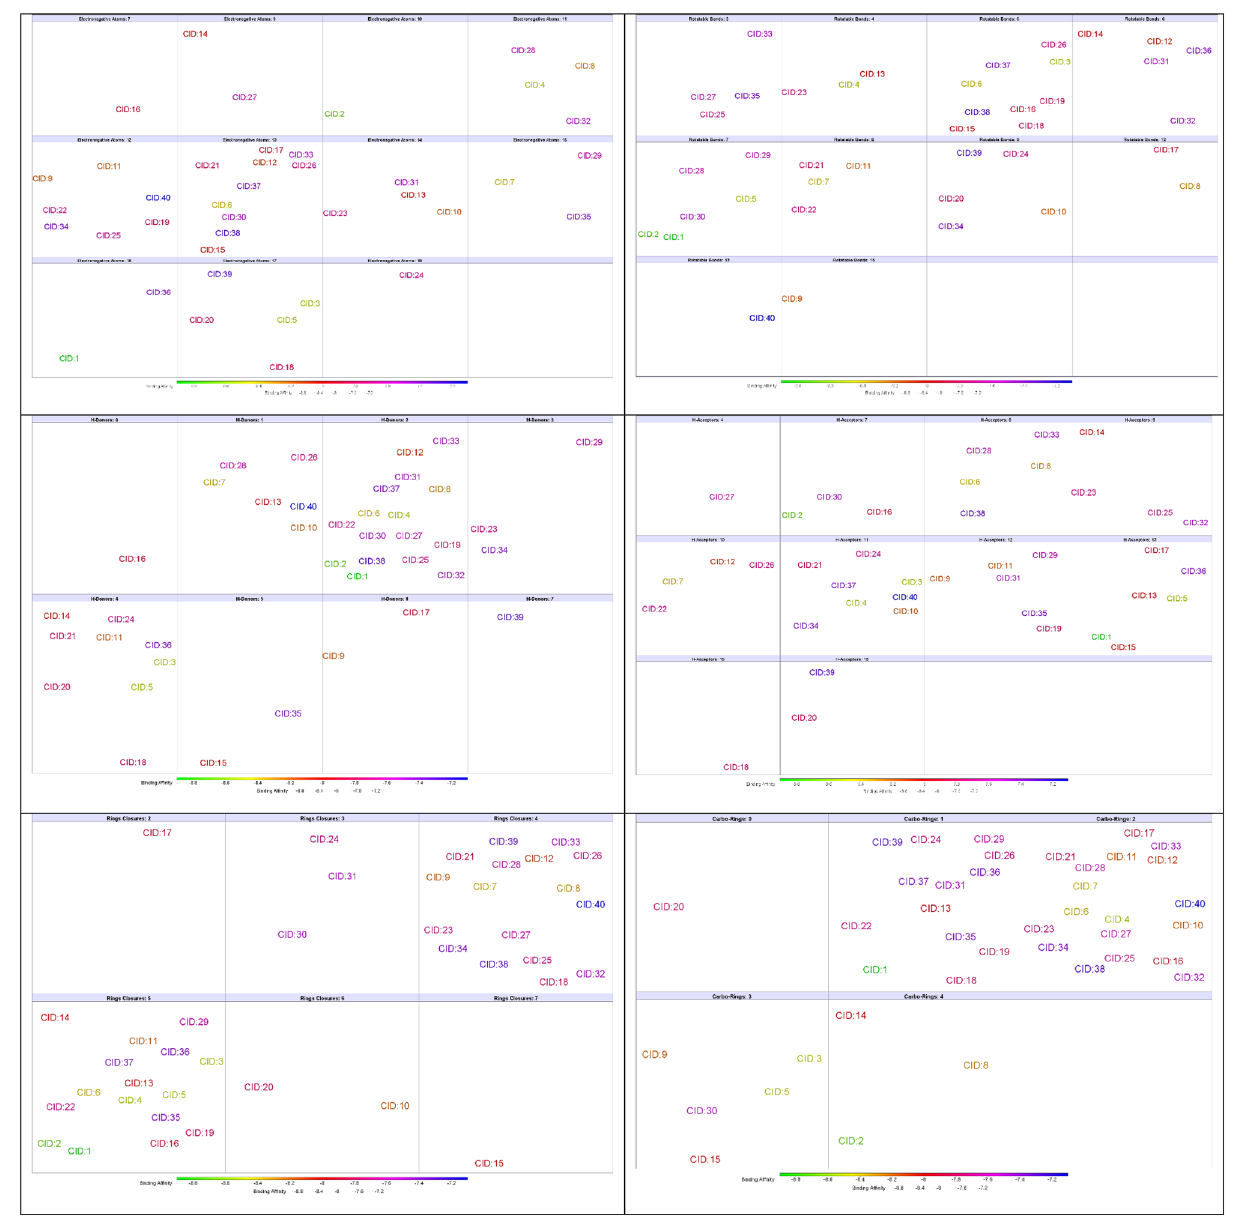
Figure 8. Distribution of the compounds into numeric groups based on their structural skeleton